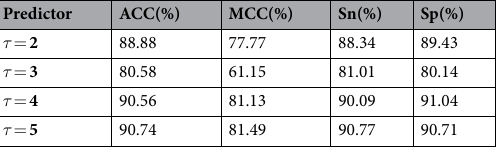
Table 1. The test results of splice donor site sequences based on different characteristic parameter τ values.